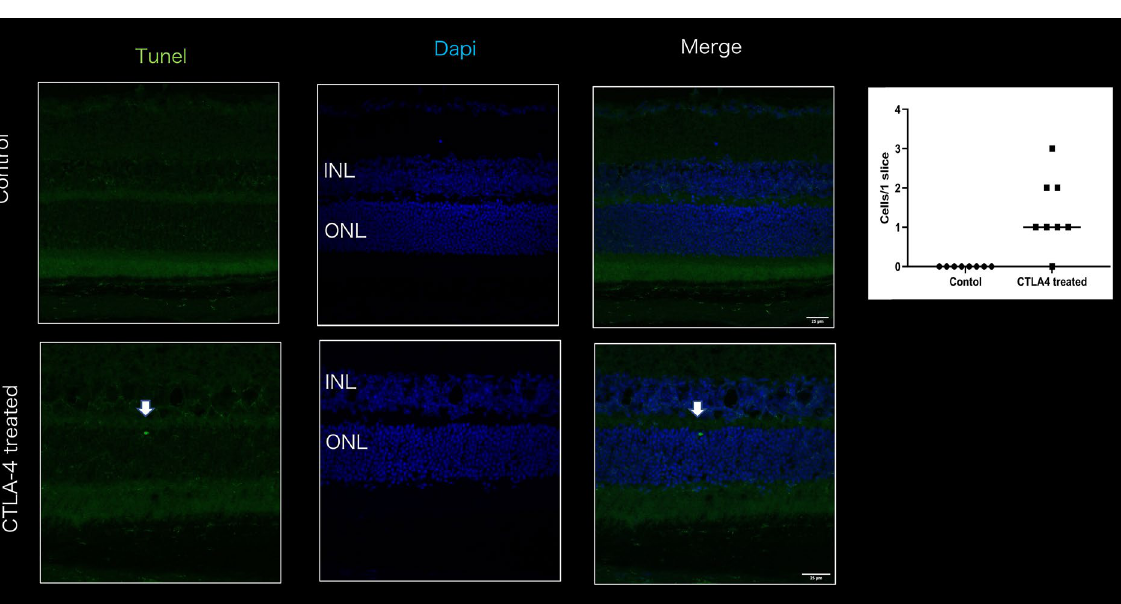
Figure 5. TUNEL staining in control and anti-CTLA4-treated eyes. Very limited numbers of TUNEL-positive cells were detected in treated eyes (n = 4 in each group). ONL: Outer nuclear layer, INL: Inner nuclear layer. The white arrows indicated the TUNEL positive cell in treated